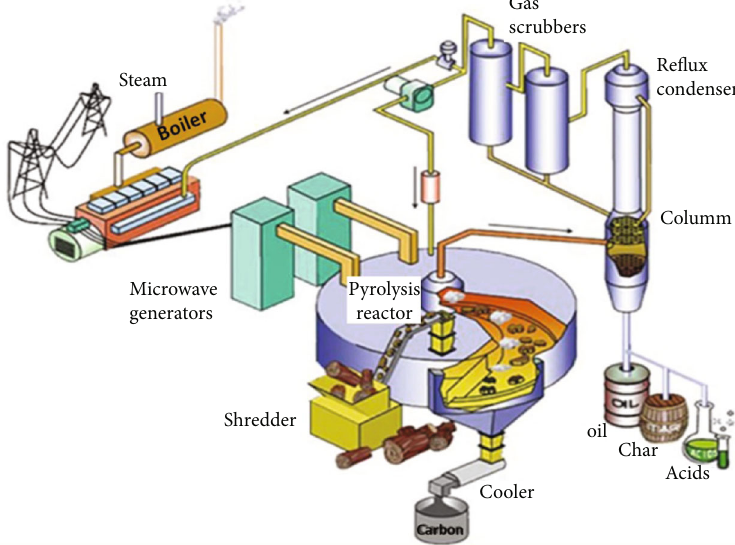
Figure 19: The pyrolysis process based on the rotating ceramic disc concept of SBC. With permission (copyright © 2007-2012 http:// SBioFuel.com).